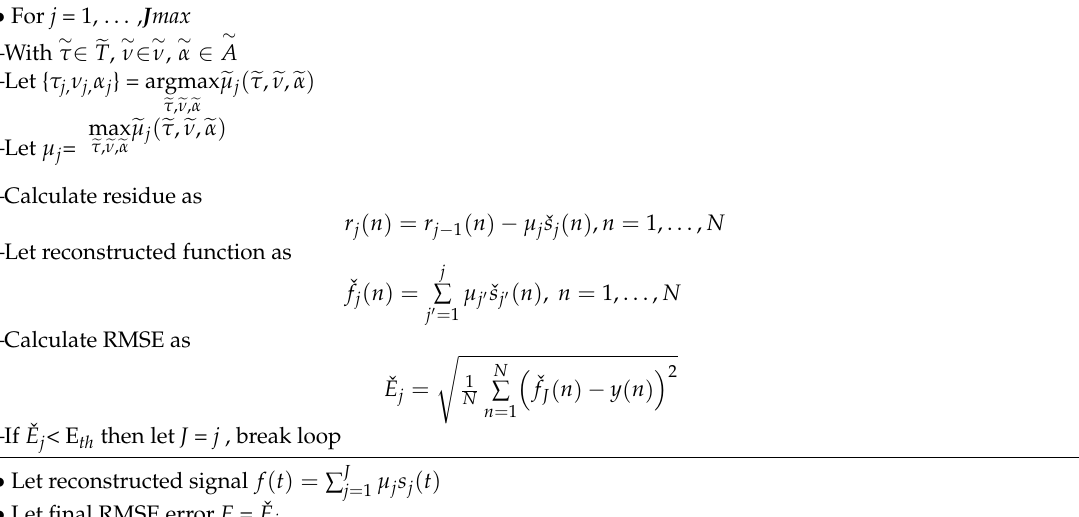
Table 2. Signal reconstruction algorithm. Table 2 . Signal reconstruction algorithm.